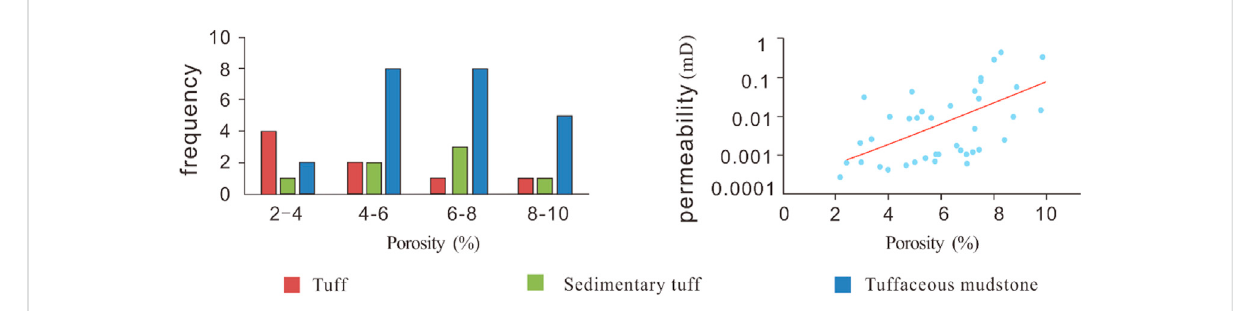
FIGURE 9 Porosity distribution and relation of tuffaceous rocks.